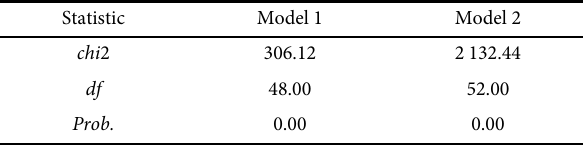
Table 4 Hausman test for the fixed effect and random effect